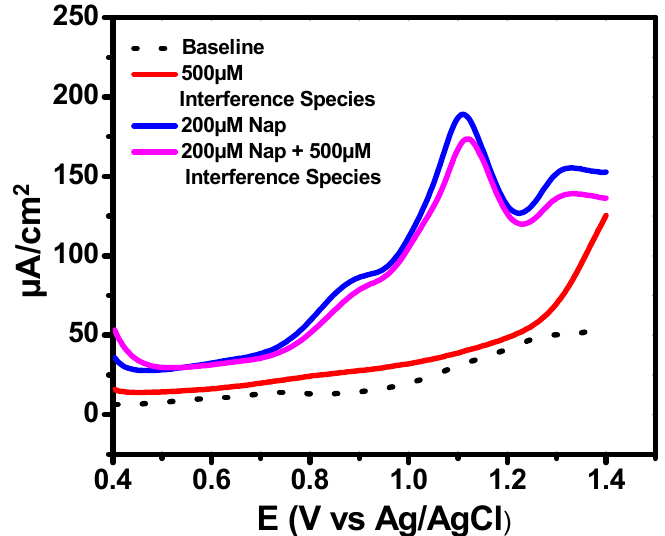
Figure 7. DPV responses showing the responses of 200 M naproxen in the presence and absence of 500 µ M chloride ions, nitrate ions, glutamic acid, glycin, citric acid, sulfate ions, ascorbic acid, and D-glucose interference species.